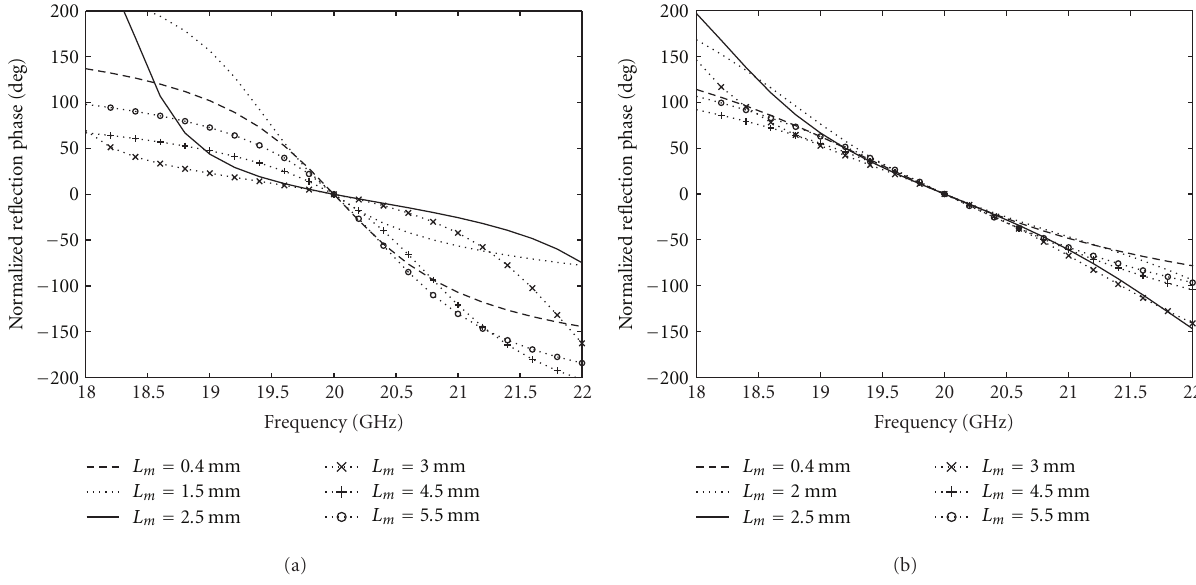
Figure 9: Calculated phase curves against frequency for various tuning line length—(a) Δ x = Δ y = 0 . 6 λ ; (b) Δ x = Δ y = 0 . 4 λ